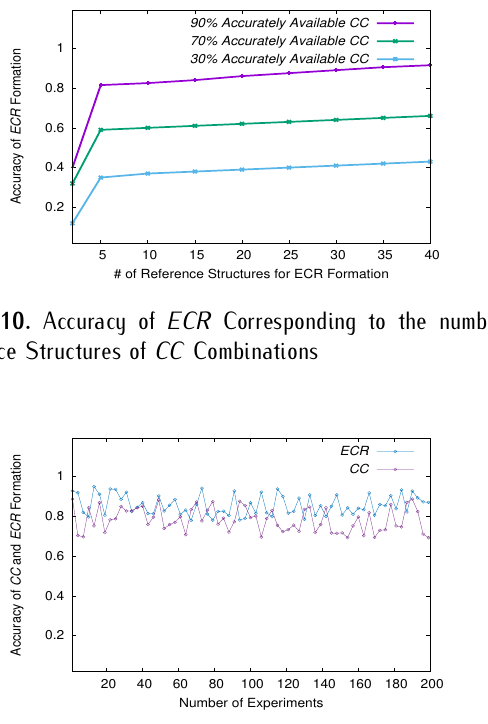
Figure 11. Accuracy of CC and ECR Formation over the Number of